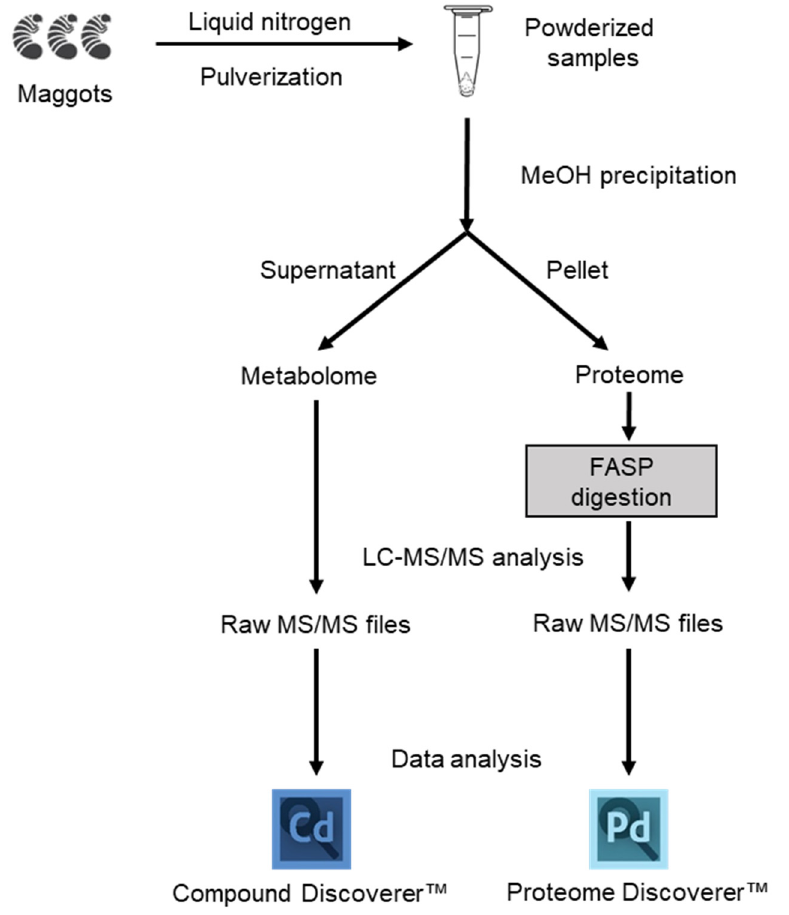
Figure 1. Schematic overview of the workflow used for proteomic and metabolomic analysis of maggot sample. Both omics were carried out simultaneously from a single precipitation procedure.